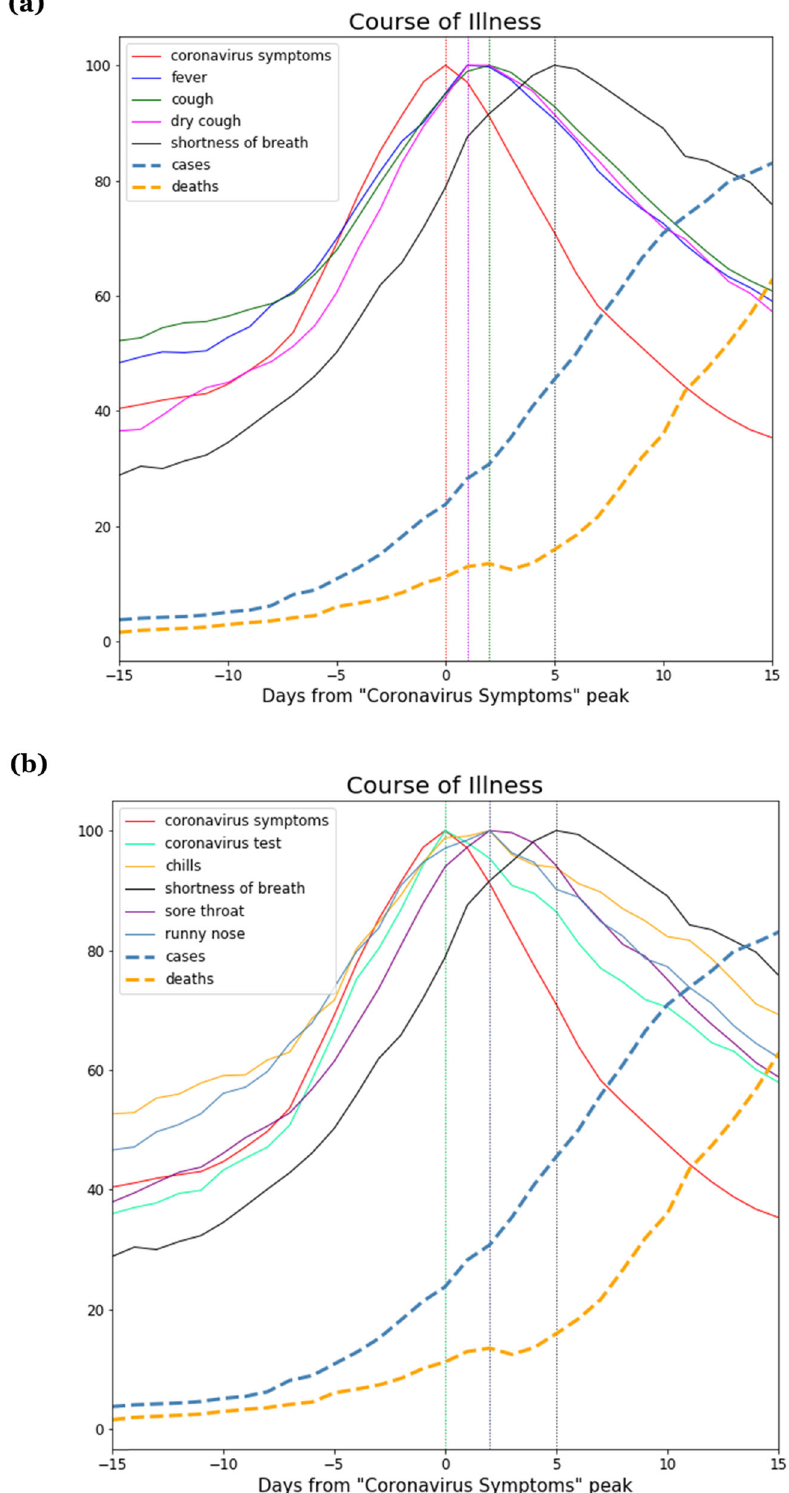
Fig. 4 Average clinical course of symptoms across 32 countries. Ensemble average clinical course of COVID-19 symptoms across 32 countries, as seen through Internet search volumes of search terms related to COVID-19 symptoms. a Search volumes for the terms “ fever ” , “ cough ” , “ dry cough ” , “ shortness of breath ” (black), indexed by searches for “ coronavirus symptoms ” , shown alongside COVID-19 cases (dashed line cyan) and deaths (dashed line orange). b Search volumes for the terms “ sore throat ” , “ runny nose ” , “ chills ” , and “ coronavirus test ” , alongside “ shortness of breath ” (black), indexed by searches for “ coronavirus symptoms ” , shown alongside COVID-19 cases (dashed line cyan) and deaths (dashed line orange).